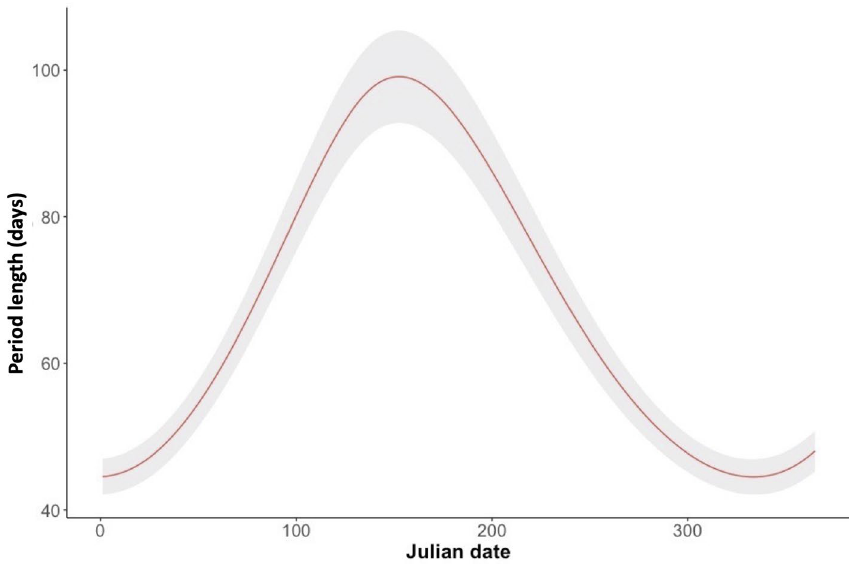
Figure 3. Values of inhabitation period length (days) of a settlement by porcupine in the province of Pisa (Italy), as predicted by the Generalised Additive Model (with a Poisson error distribution) including settlement, reproductive status, Julian day, and family ID as predictor variables, sample size = 2221. The figure shows the effects exerted by Julian date. The predictions are given setting settlement = main, reproductive status = 1, cohabitation = 0, and family ID = 1. In the graph the colour-shaded areas are the estimated standard